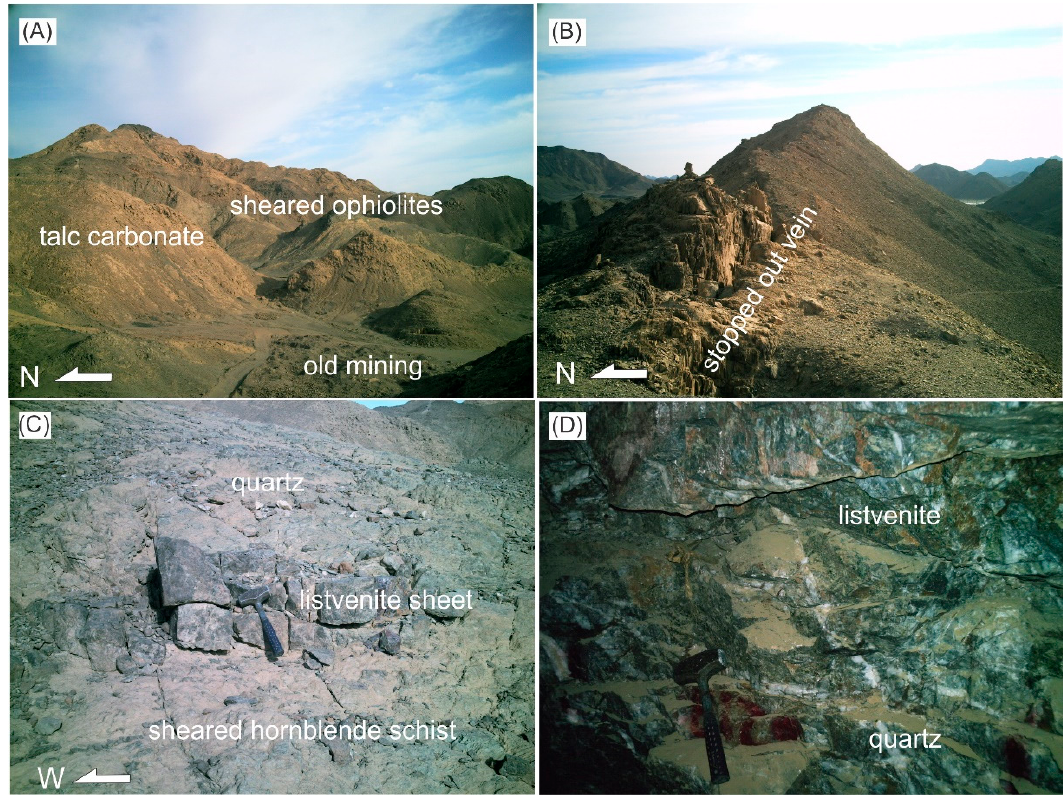
Figure 13. Field relationships at the Barramiya mine area and its surroundings, including: ( A ) Sheared ophiolitic serpentinite and talc carbonate exposures north of the Barramiya mine where scattered old mining activities are observed, ( B ) ~E–W trending quartz vein significantly worked out by old miners and still preserves the trend of the main lode of the Barramiya deposit, ( C ) Listvenite sheet embedded within shear hornblende and actinolite schist north of the Barramiya mine, and ( D ) Typical listvenite exposure in the underground mine levels dissected by milky quartz veins.